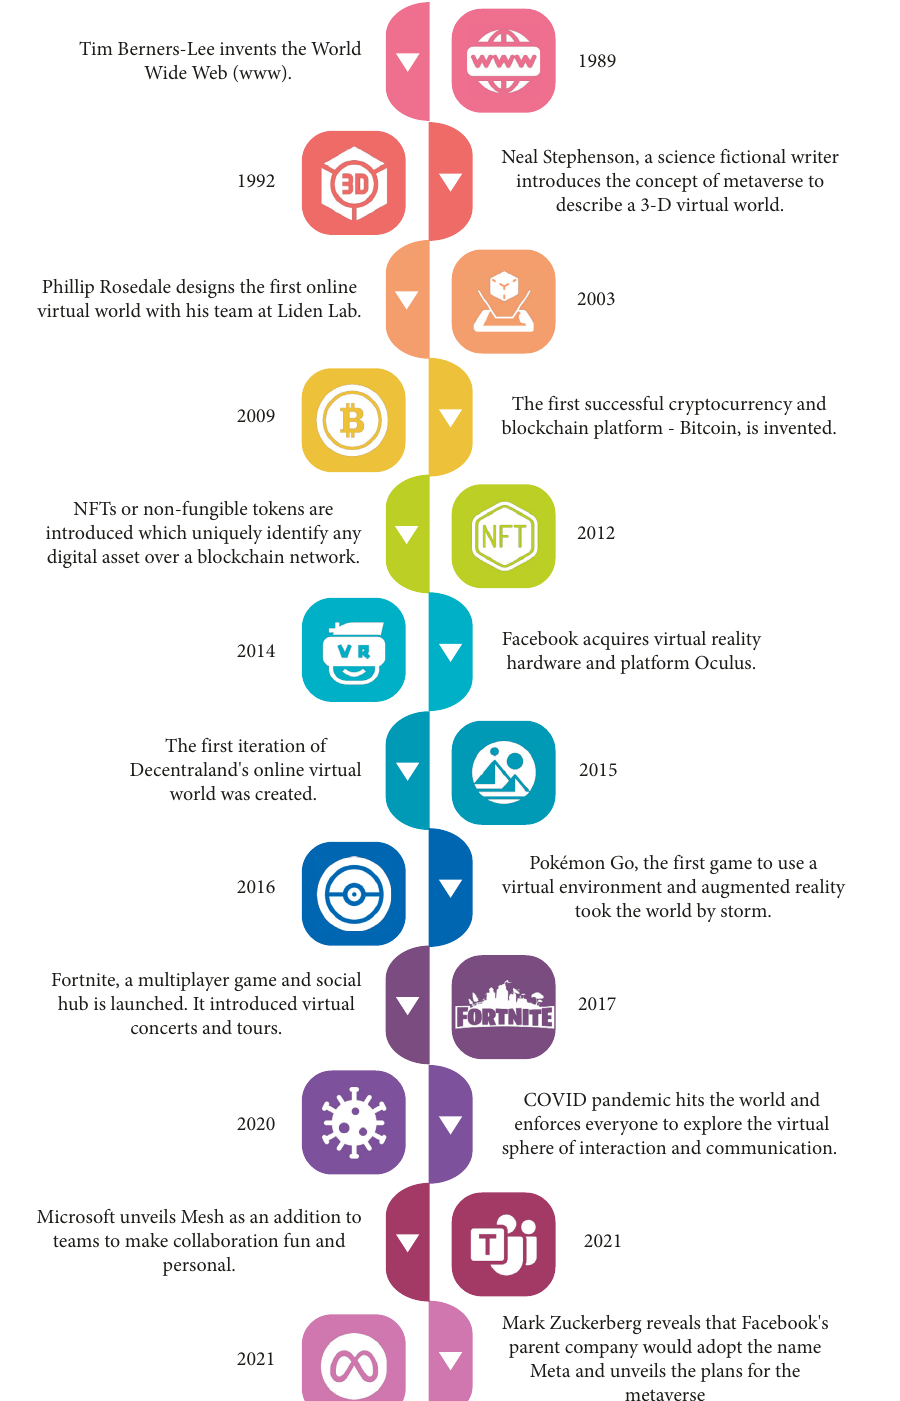
Figure 2: Historical events that led to the emergence of the